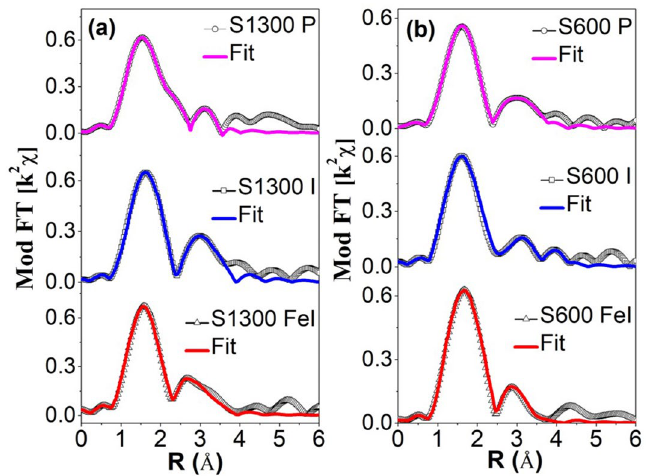
Figure 3. Magnitude of the Fourier transform (FT) of EXAFS functions (k 2 χ (k) ) for pristine and irradiated S600 and S1300. S1300 P and S600P are the respective pristine samples.